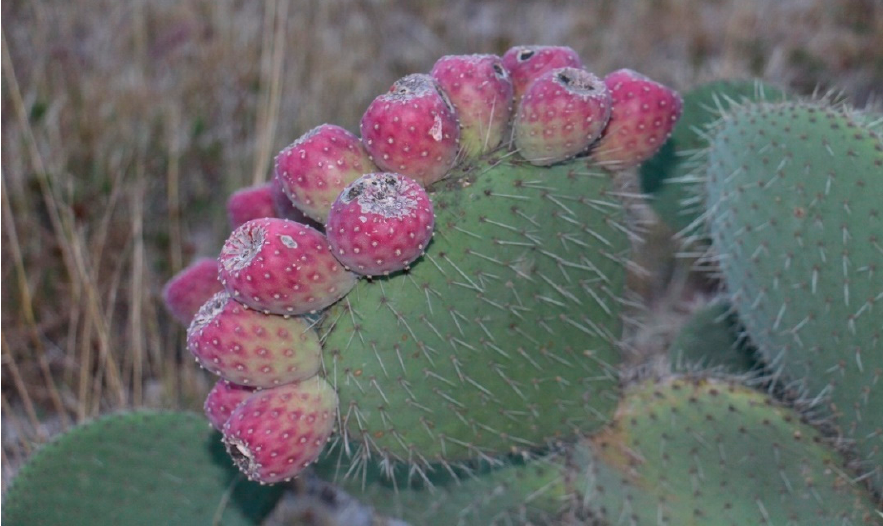
Figure 5. Xoconostle plant (O. Oligacantha C.F. Först var “Ulapa”).